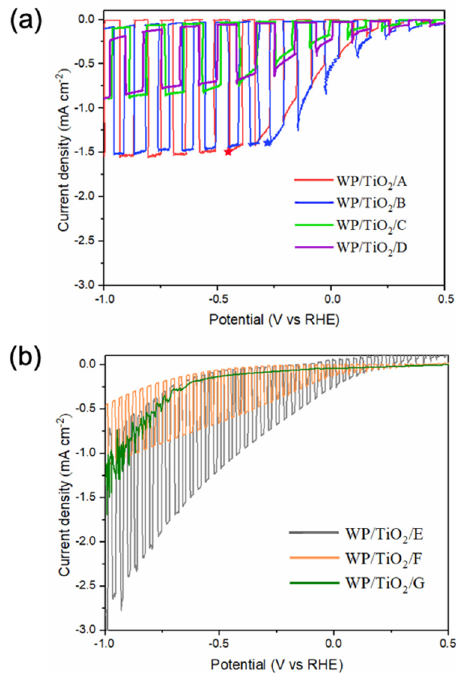
Figure 4. Chopping I-V curves measured on samples A–D ( a ) and E–G ( b ) with WP/TiO 2 coatings on p-GaP surface in 1M KOH electrolyte. Potential is replotted with respect to reversible hydrogen electrode (RHE).